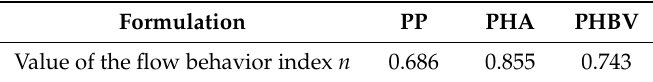
Table 4. Value of the flow behavior index of the different feedstock.